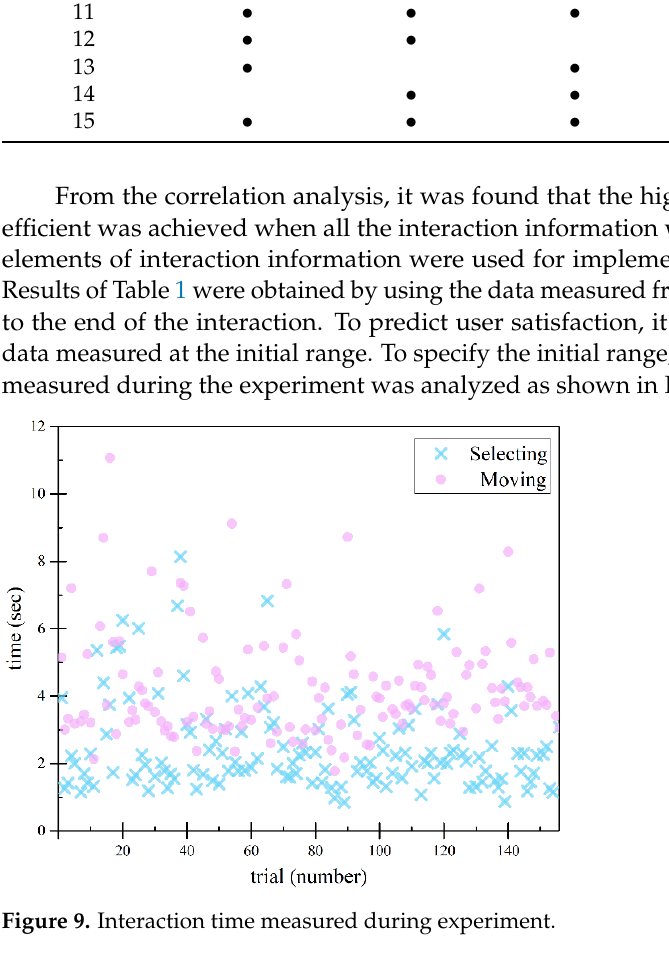
Table 1. Correlation between each measured interaction-information combination and user satisfaction.